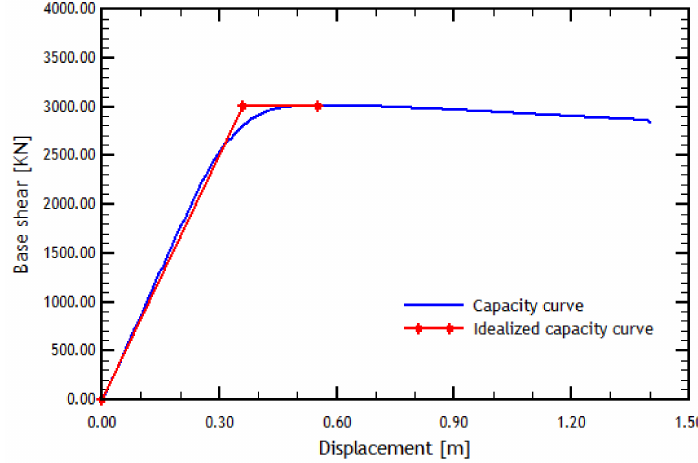
Figure 9. Capacity and idealized curve, transverse